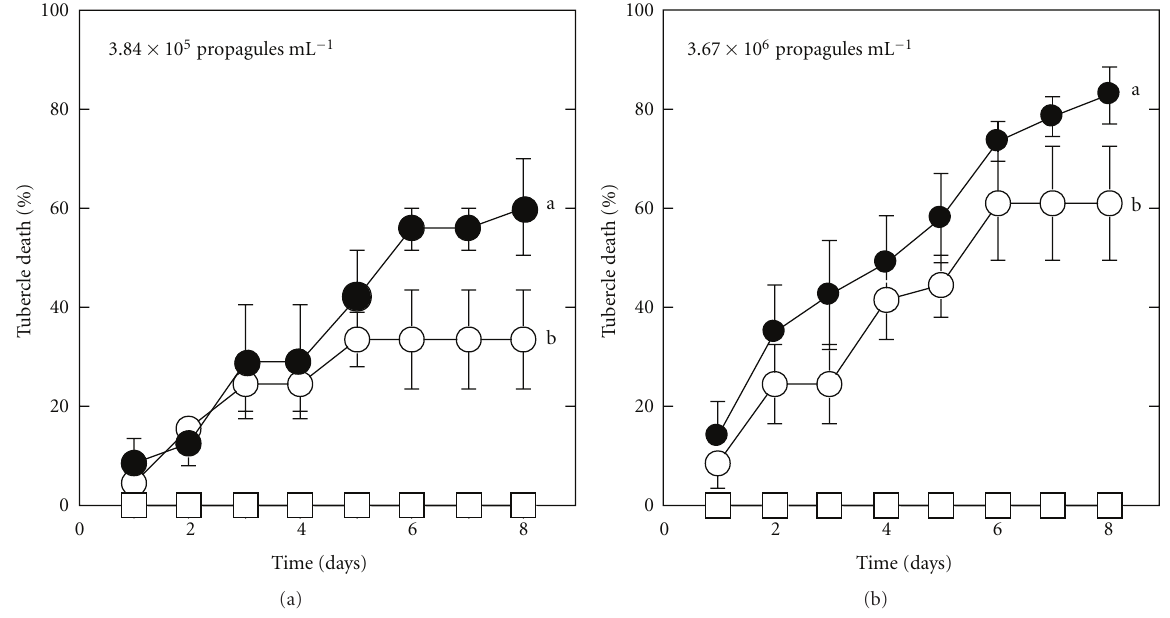
Figure 1: Pectinase enhanced F. compactum infection of broomrape growing on tomato roots. Correlation between tubercle mortality of broomrape and fungal inoculum level with • or without ◦ pectinase (a) 3.84 × 10 5 ; (b) 3.67 × 10 6 propagules ml − 1 . Tubercle mortality is represented by percentage of dead tubercles (dark brown, soft to touch, rotten) compared to the total number of tubercles present on plant roots at the time of inoculation. The trial was conducted twice, each treatment with three replications.